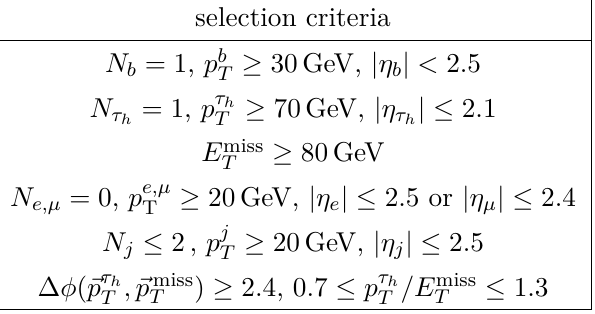
Table 1 . Summary of kinematic